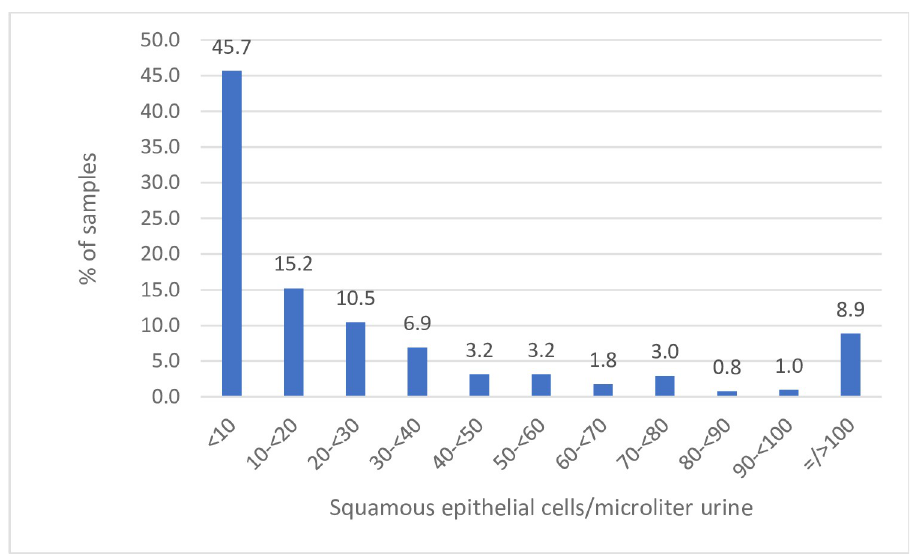
Fig 3. Number of squamous cells in contaminated samples.